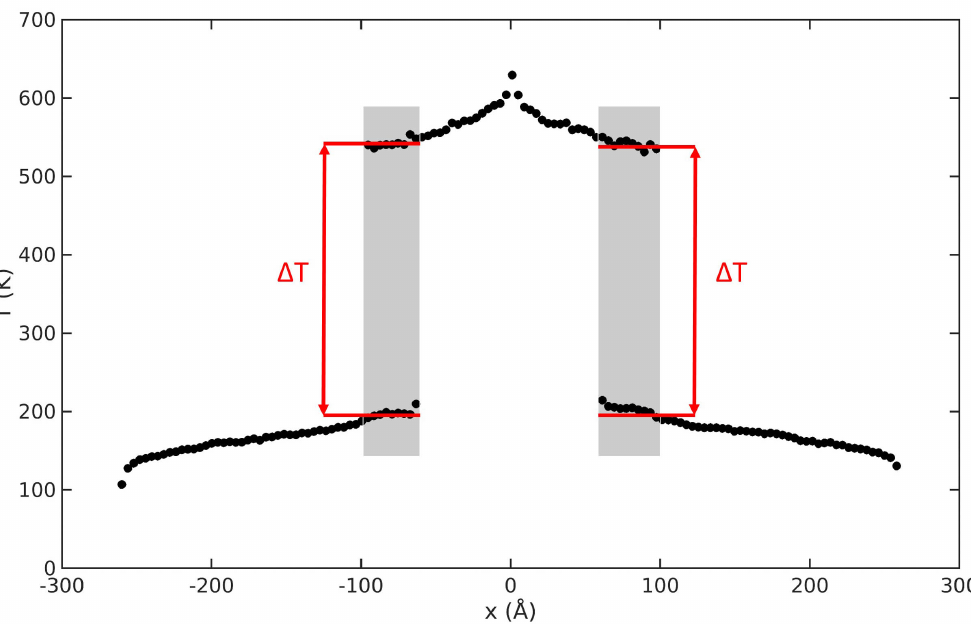
Figure 2. Steady state temperature profile through a representative network of 3 GNRs, as achieved in the reverse non-equilibrium molecular dynamics simulation. The average temperature jump ( ∆ T ) at the interface between overlapping GNRs (grey rectangles) is employed in Equation (1) to compute R k